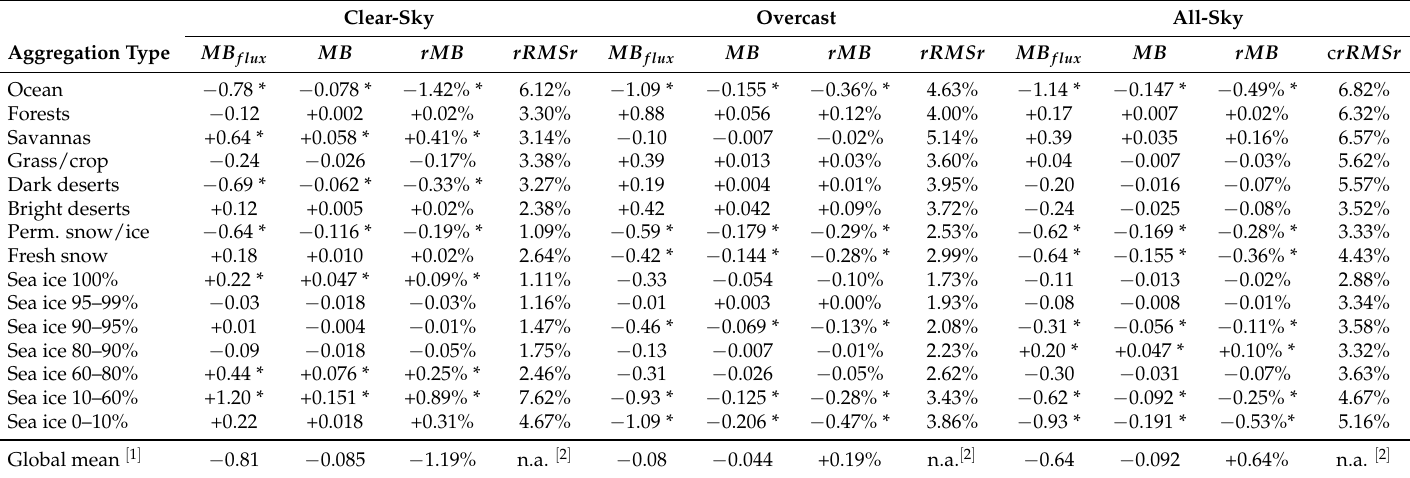
Table 6. Surface-type-dependent regression performance based on expanded database (with relaxed matching criteria), stratified per surface type, for clear, overcast, and allsky conditions; Data: 2004-2005 (NOAA17+Terra), 2007-2008 (NOAA18+Aqua) and 2011–2012